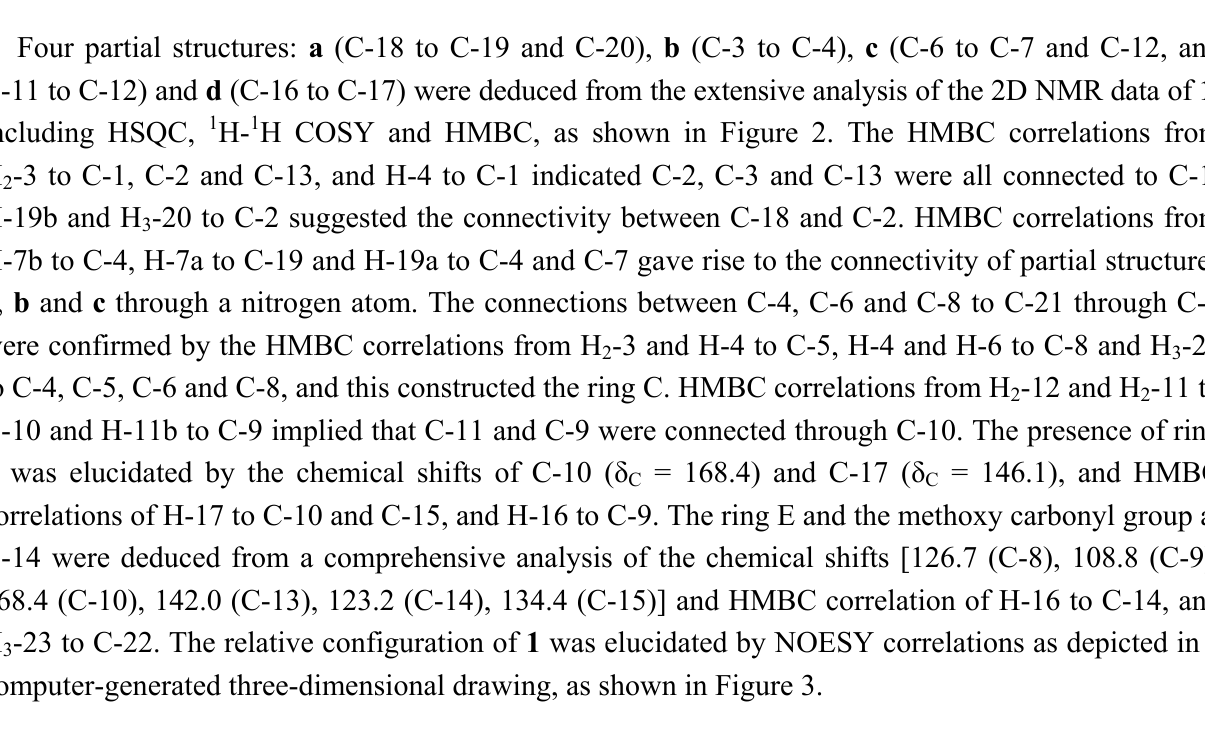
Figure 2. Selected 2D NMR correlations of daphnicyclidin M ( 1 ).